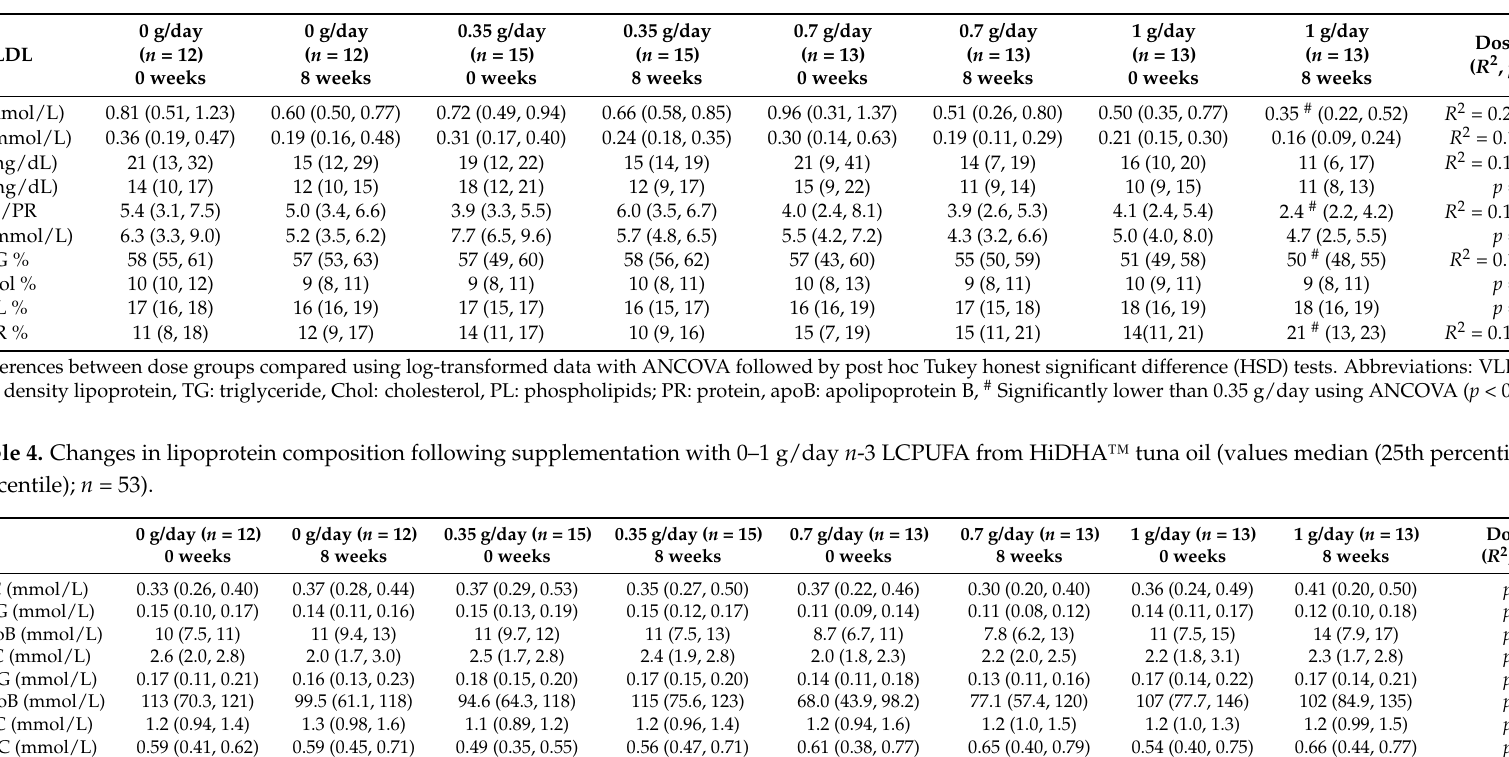
Table 3. Changes in VLDL particle composition following supplementation with 0–1 g/day n -3 LCPUFA from HiDHA™ tuna oil (values median (25th percentile, 75th percentile); n = 53).